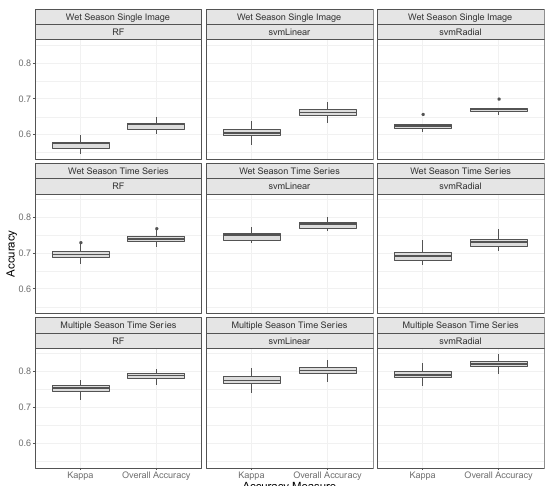
Figure 3. The effect of classifier and image sets on Overall Accuracy (OA) and Kappa coefficients. Figure 3. The e ff ect of classifier and image sets on Overall Accuracy (OA) and Kappa coe ffi cients. Distributions of accuracy coefficients were obtained from 100 replicates. Distributions of accuracy coe ffi cients were obtained from 100 Confusion matrices were produced from the mean entries from 100 model replicates and normalized to show percentages to make classes directly comparable [59]. Normalizing confusion matrices is a common practice in assessing classification map accuracies, but tends to bias user accuracy (UA) and producer accuracy (PA) statistics if sample sizes vary considerably between classes (see Table 3 for class sample sizes). As a consequence of an unbalanced training data set, these statistics were not calculated, and the confusion matrices alone demonstrate class accuracy trends across classifiers and image sets (Figure 4) [60].